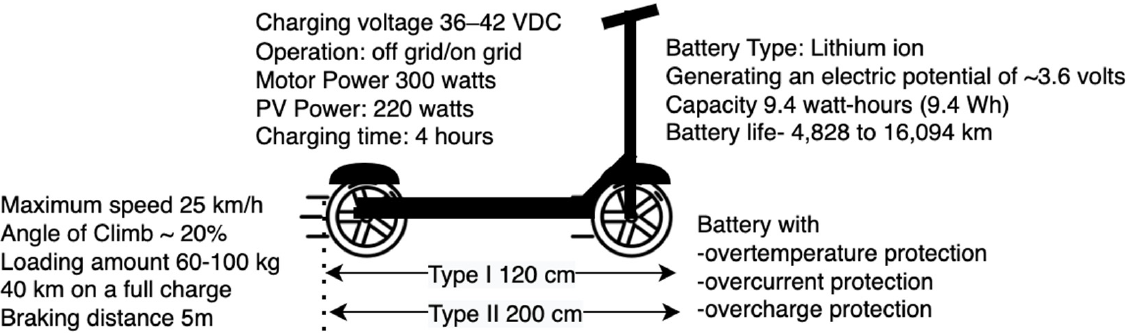
Figure 3. Technical specifications of the e-scooter.